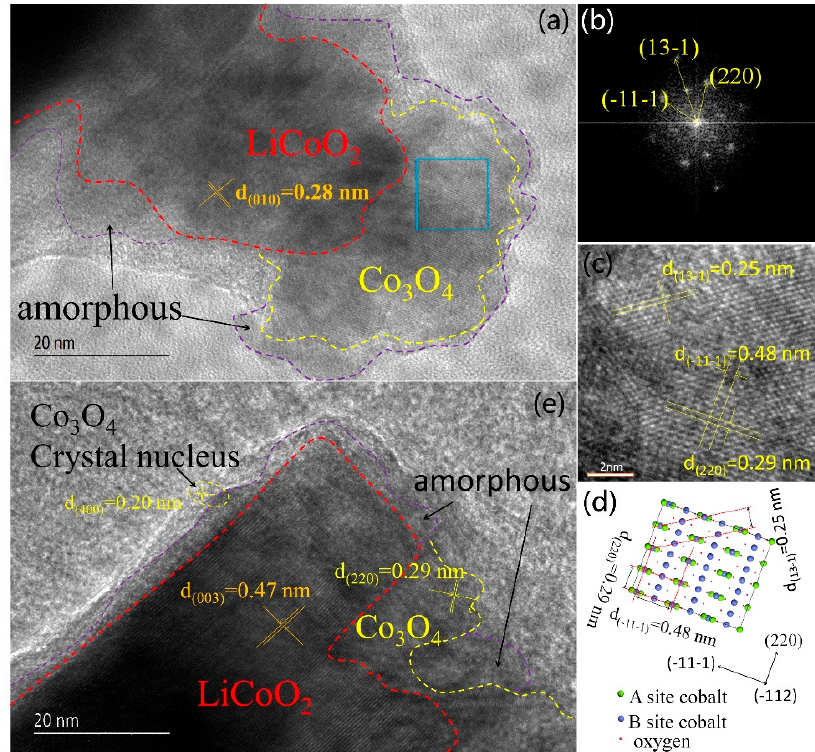
Figure 1. The Coulombic efficiency of Li-ion coin-cell with LiCoO 2 as cathode materials.